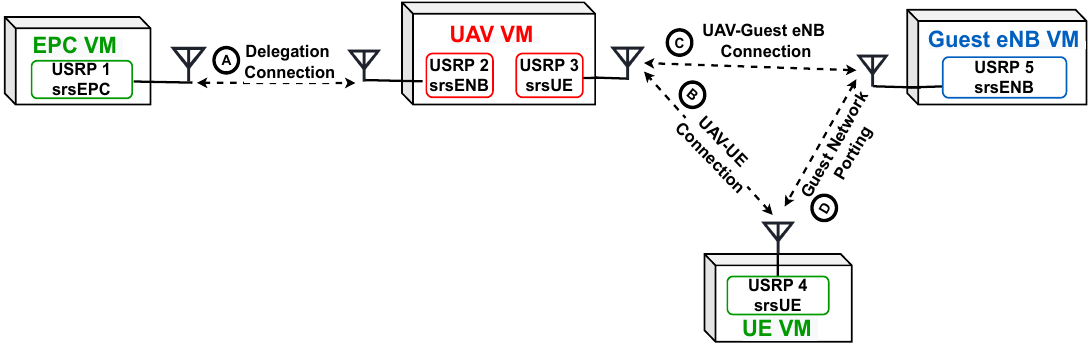
Figure 4. The experiment implementation